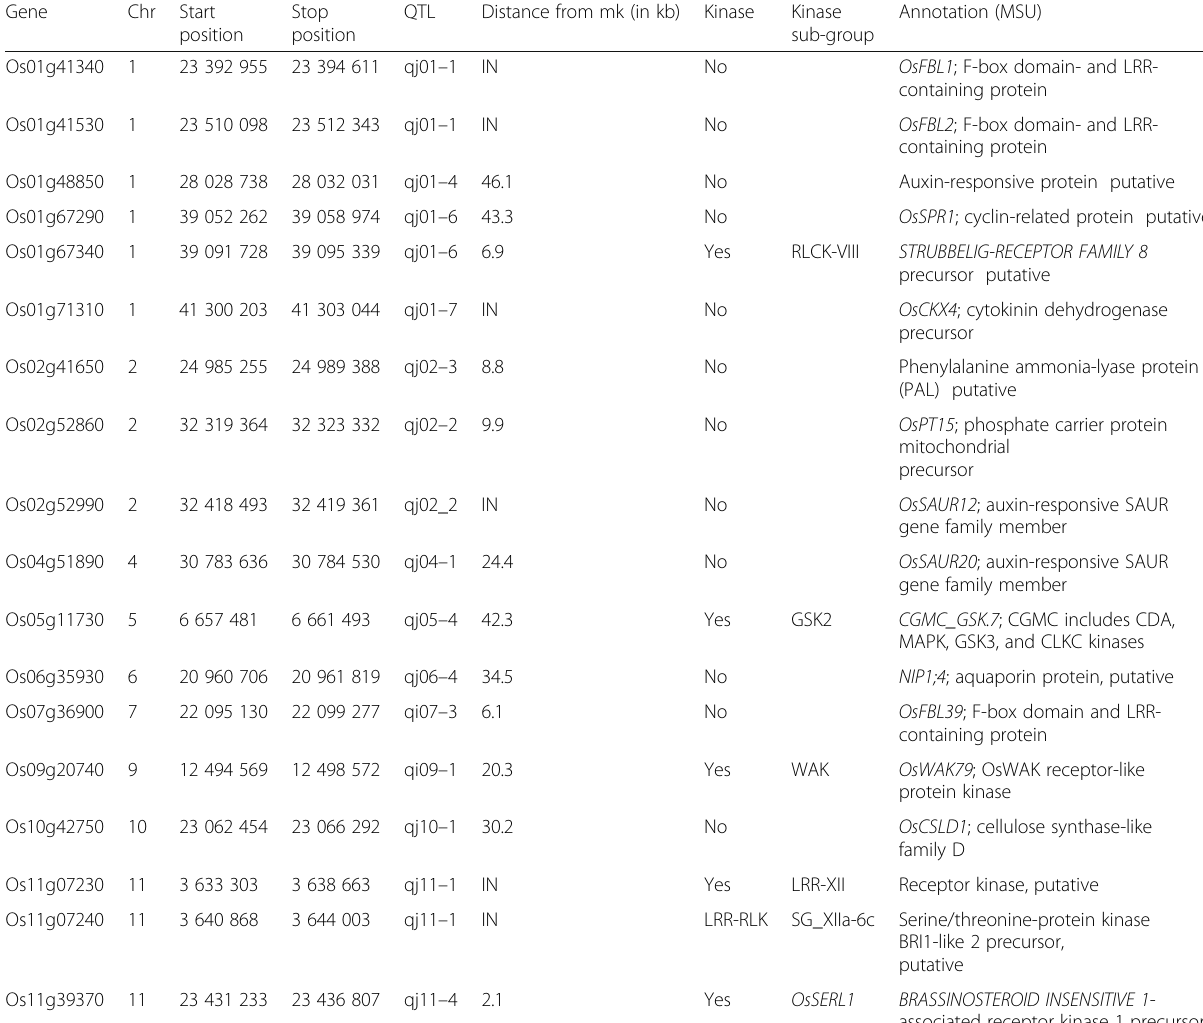
Annotation (MSU) sub-group